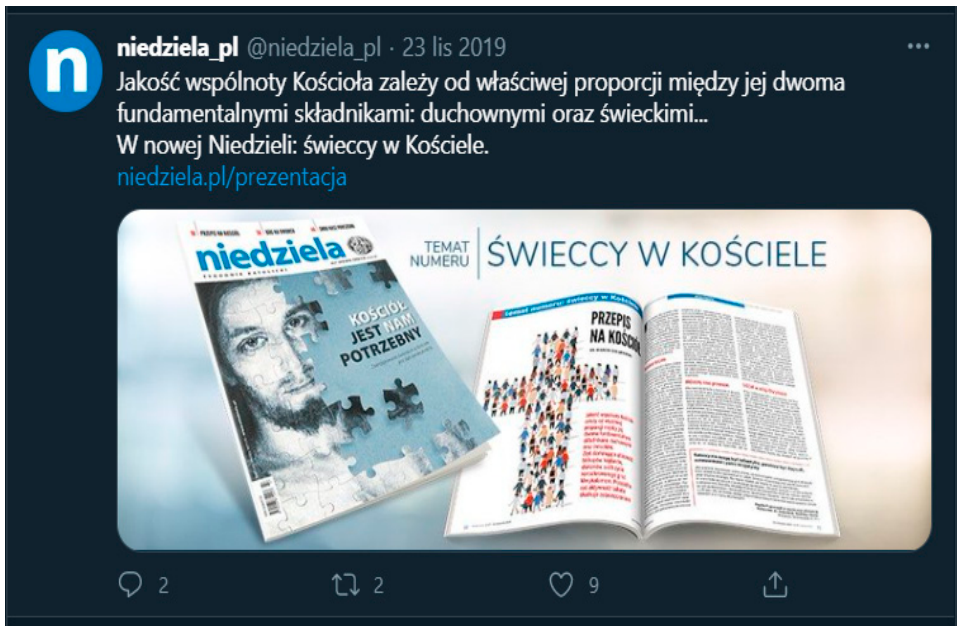
Figure 1. A self-promotional tweet by Tygodnik Katolicki Niedziela , 23.11.2019. Source: Twit- ter/screenshot.